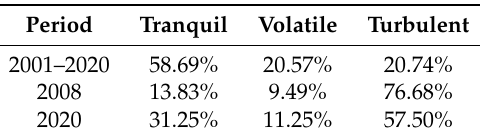
Table 6. Percentage of time spent by the Dow Jones Industrial Average index in each regime: ratio between number of days in regime i and number of days in the whole period.